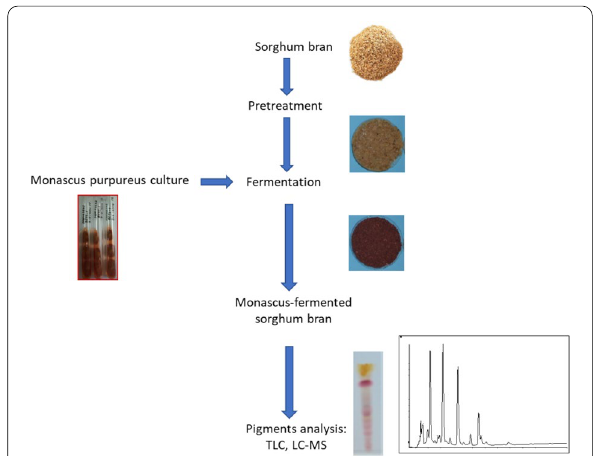
Fig. 1 Solid‑state fermentation of sorghum bran with Monascus purpureus for pigments production